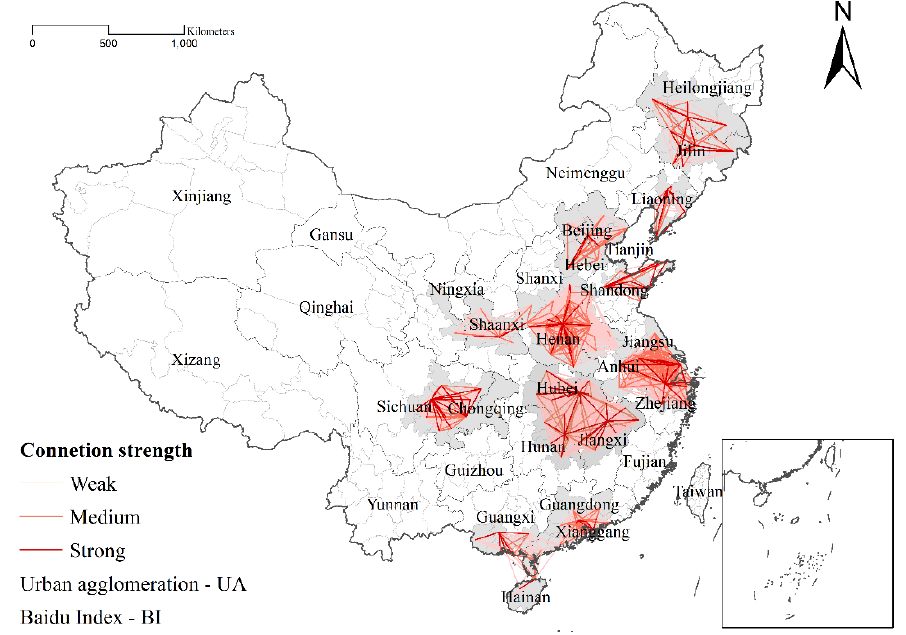
Figure 3. City connection network of 11 UAs based on the BI.